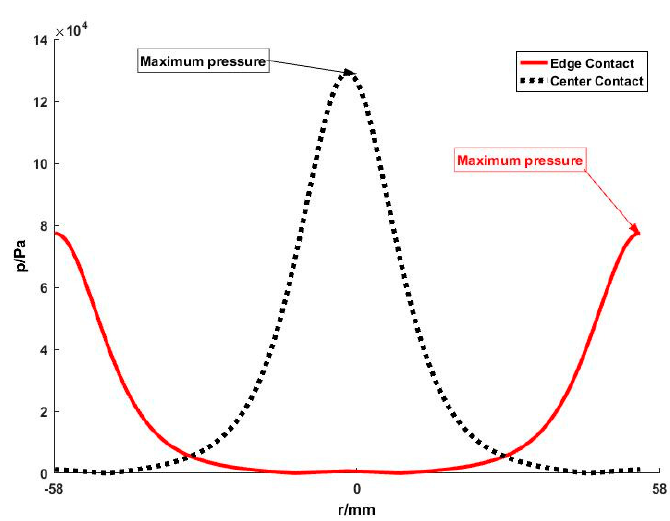
Figure 4. Pressure distribution of different receipts: the maximum pressure occurs at the contact position and it is much lower for the edge contact compared with the center contact.